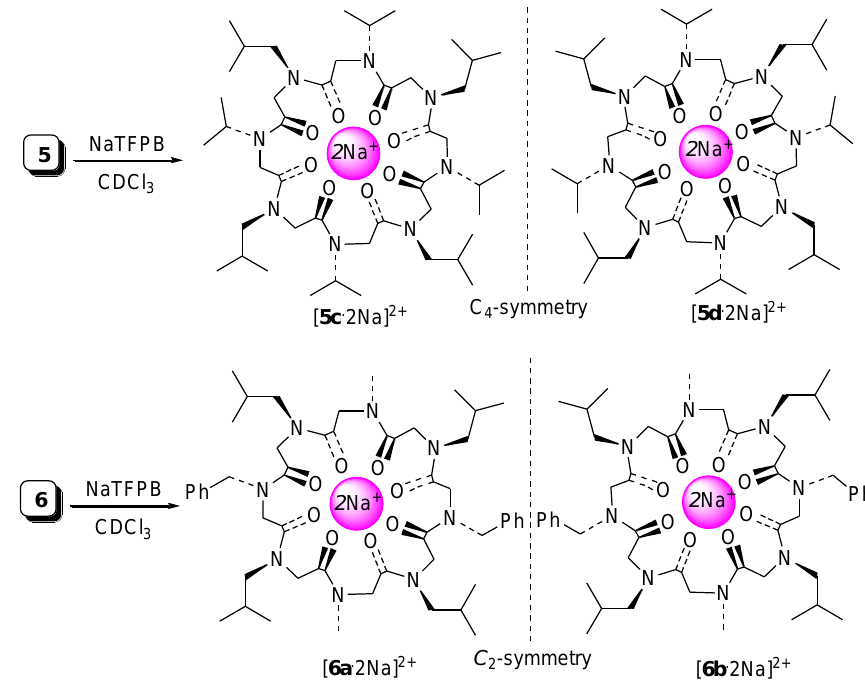
Figure 7. Schematic structures of both the enantiomers of all - trans Na + -complexes of cyclic octamer peptoids 5 and 6 . C 4 -symmetric [ 5c · 2Na] 2+ /[ 5d · 2Na] 2+ and C 2 -symmetric [ 6a · 2Na] 2+ /[ 6b · 2Na] 2+ are non-superimposable mirror images. Amide bonds are considered as rigid planes.